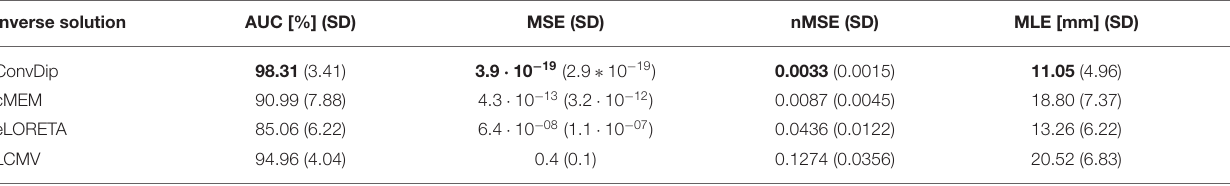
TABLE 1 | Comparison of inverse algorithm performance for samples containing a single source cluster. Inverse